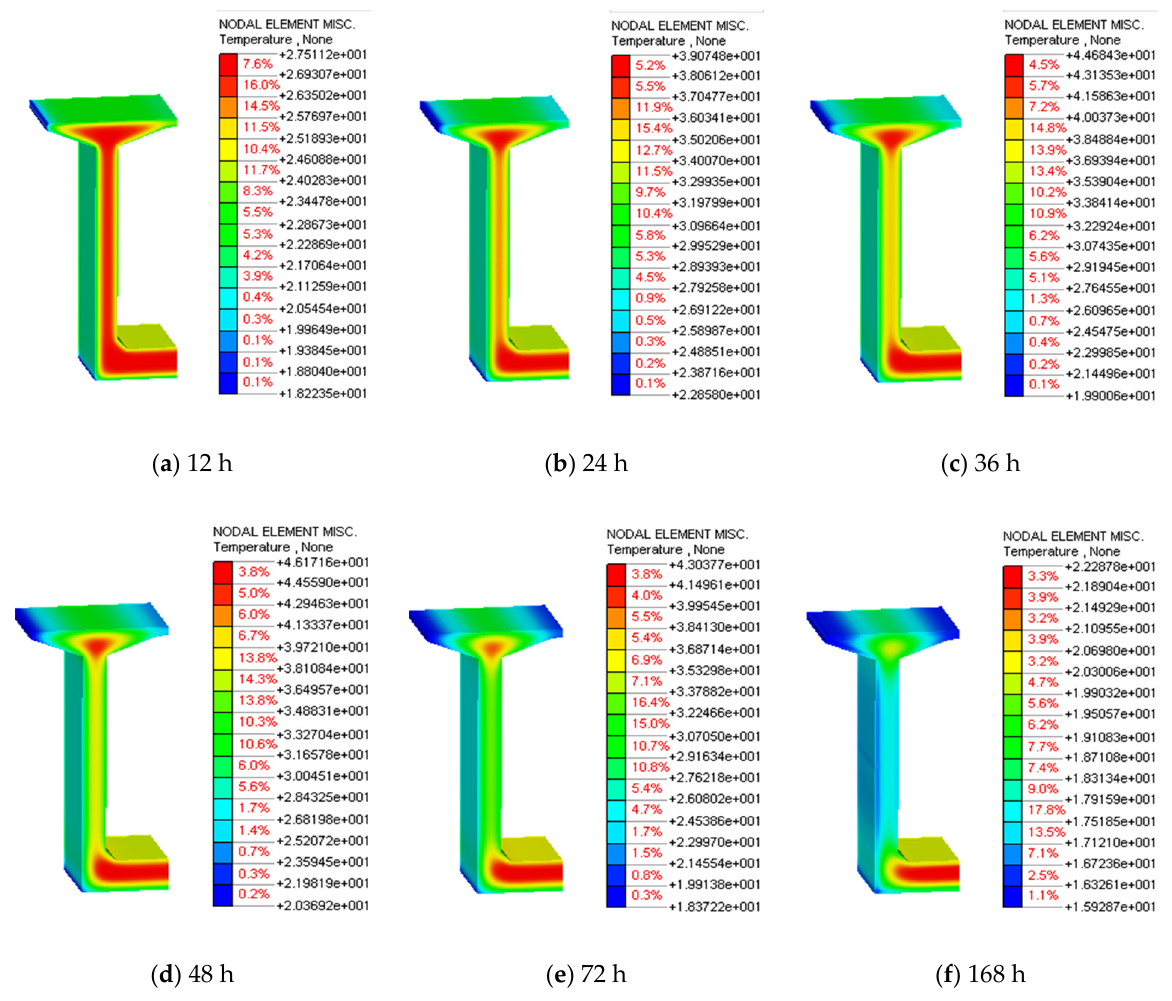
Figure 7. Temperature field distribution of the box girder at each key moment.